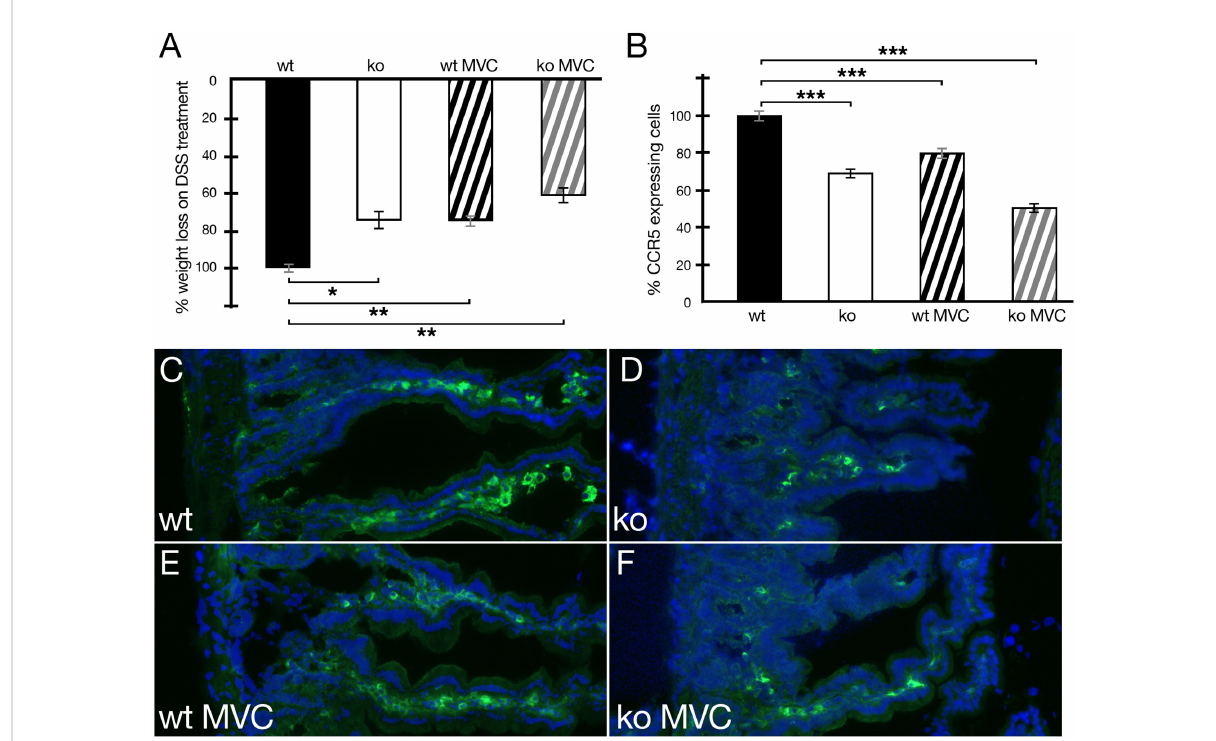
FIGURE 3 Weight loss of animals under DSS treatment with and without maraviroc (MVC) in drinking water in wild-type (wt) and periostin-de fi cient (ko) animals. (A) The weight loss observed in wt animals under DSS treatment was set to − 100% (wt, black histogram). The weight loss as one read out of IBD severity for the wt cohort was − 12.35% on average. The ko cohort (ko, white histogram) lost 9.37% on average and 9.39% on average for wt+MVC (black striped histogram) reducing the weight loss in both cohorts to 76%. The ko+MVC cohort (gray striped histogram) lost 7.79% on average leading to an overall weight reduction to 63% compared to wt animals under DSS treatment only. (B) Con fi rming our previous results, the absence of periostin results in the reduction of CCR5-expressing cells in the in fl amed small intestine ( − 30%) (white histogram). The addition of MVC in drinking water has a similar effect ( − 20%) (black striped histogram). Interestingly, MVC in drinking water in periostin-de fi cient animals (gray striped histogram) has the strongest effect and suggests that the effects are additive ( − 45%). All differences in (B) are highly signi fi cant ( P < 0.005). (C – F) Representative capture of small intestine sections from wt (C) , ko (D) , wt with MVC treatment (E) , and ko with MVC treatment (F) animals under DSS showing an immuno fl uorescence staining using a CCR5 antibody (green) and DAPI (blue). Immuno fl uorescence analysis shows the degree of reduction of the number of CCR5-expressing cells in sections derived from the in fl amed small intestine in MVC-treated wt animals (E) , periostin-de fi cient animals (D) , and periostin-de fi cient MVC-treated animals (F) compared to sections derived from wt animals (C) under DSS treatment. At least three animals and between fi ve and seven areas in at least three sections were used for determining the numbers for the graphs in (A, B) . *P < 0.05, **P < 0.01. and ***P <